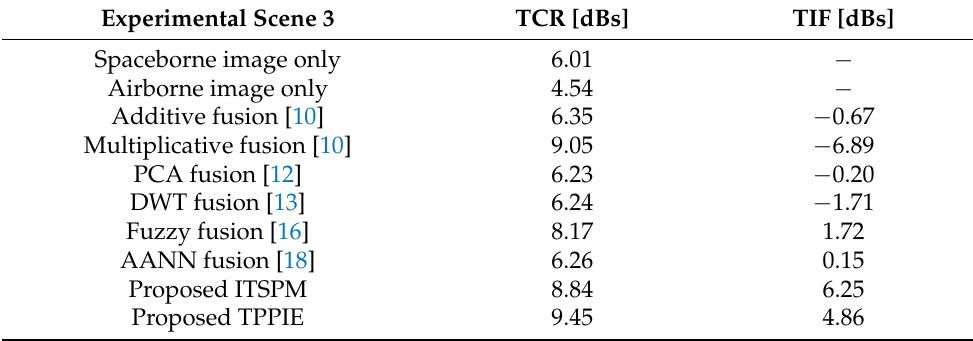
Table 4. TCR and TIF (in dBs) comparisons for Experimental Scene 3. The proposed TPPIE method attained the highest TCR and the proposed ITSPM method attained the highest